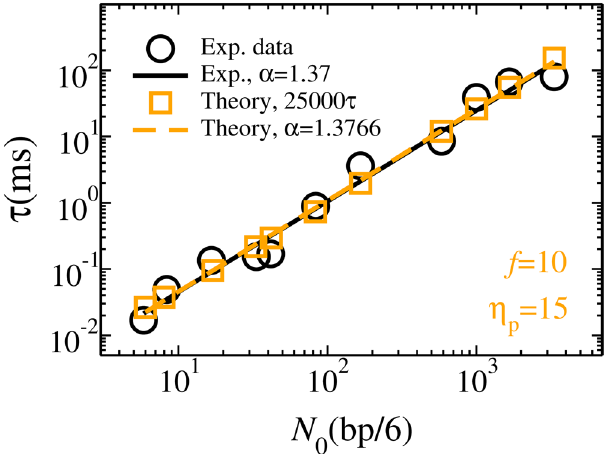
Figure 5. Translocation time τ as a function of the chain length N 0 . Black circles are experimental data in Fig. 6(c) of ref. 14 while orange squares are data from the IFTP theory, where we have used the coarse grained model. Each bead contains 6 bps. The value of the external driving force in the IFTP theory is f = 10 and the pore friction is η p = 15. The translocation time for the IFTP theory has been multiplied by a factor of 25000 to agree with the experimental time scale. The black solid and orange dashed lines are linear fitting curves to experimental and IFTP theory, respectively. Similar results can be obtained for the values of the external driving forces f = 5 and 20. Details on mapping the experimental data to theory are explained in Sec. I of the